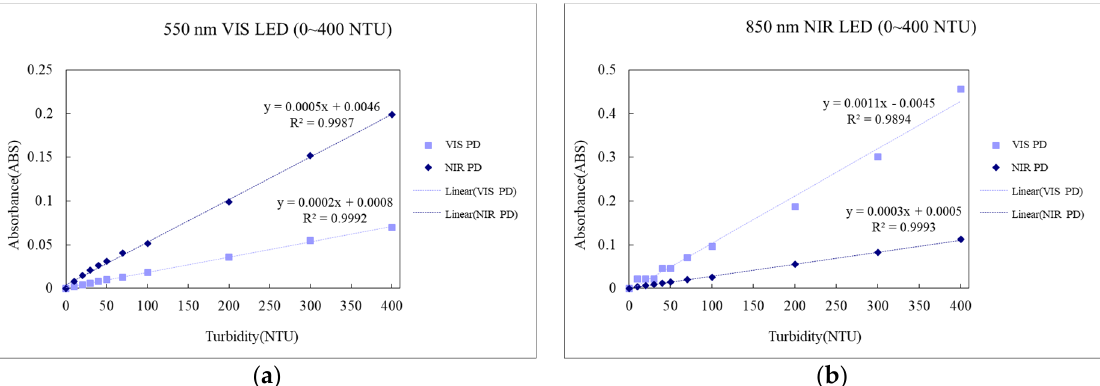
Figure 5. Results of testing of turbidity sensing modules for absorbance. ( a ) 550 nm LED. ( b ) 850 nm LED.